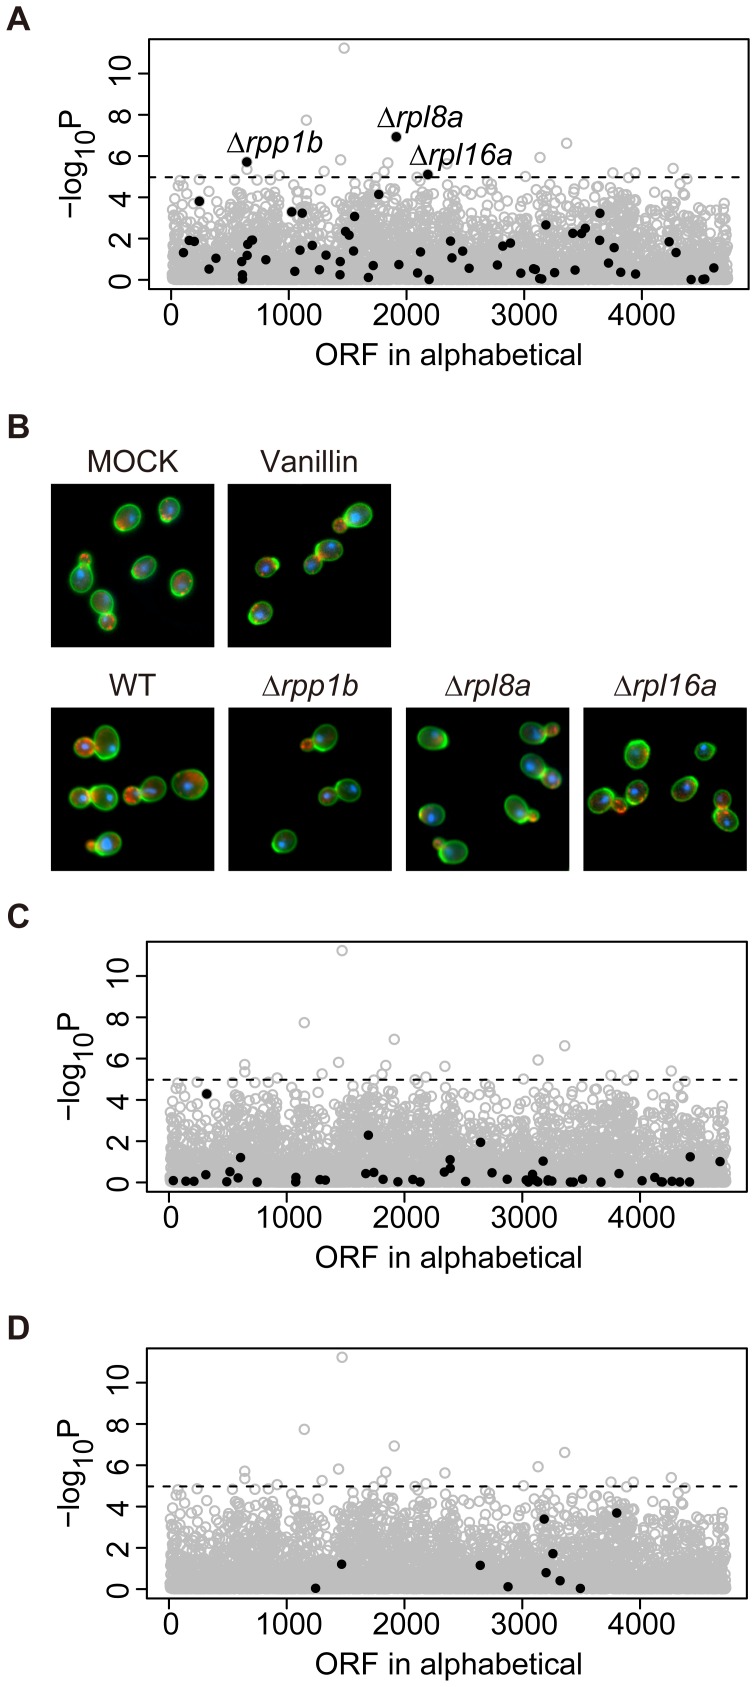
Distribution of morphological similarity between vanillin-treated cells and non-essential deletion mutants.Morphological data of wild-type cells incubated with various vanillin concentrations were used to infer the cellular processes affected by vanillin, as described previously [11]. The X-axis shows the ORFs in alphabetical order. The Y-axis indicates –log10 P of the correlation coefficient (R) between morphological profiles of vanillin-treated cells and that of each of the 4,718 non-essential gene deletion mutants (grey circles). The horizontal dashed line indicates a P value of 0.05 after Bonferroni correction. (A) Distribution of the cytosolic large ribosomal subunit (GO:0022625) mutants (black filled circles). (B) Photographs of Δhis3 Δadh6 cells treated with 0.1% DMSO (MOCK), Δhis3 Δadh6 cells treated with 1 mM vanillin (Vanillin), Δhis3 (WT), and the significantly similar deletion mutants of the large ribosomal subunit. Cells were stained with FITC-ConA (green) for cell wall, Rh-ph (red) for actin and DAPI (blue) for DNA. (C) Distribution of the cytosolic small ribosomal subunit (GO:0022627) mutants (black filled circles). (D) Distribution of the ergosterol biosynthetic pathway (GO:0006696) mutants (black filled circles).